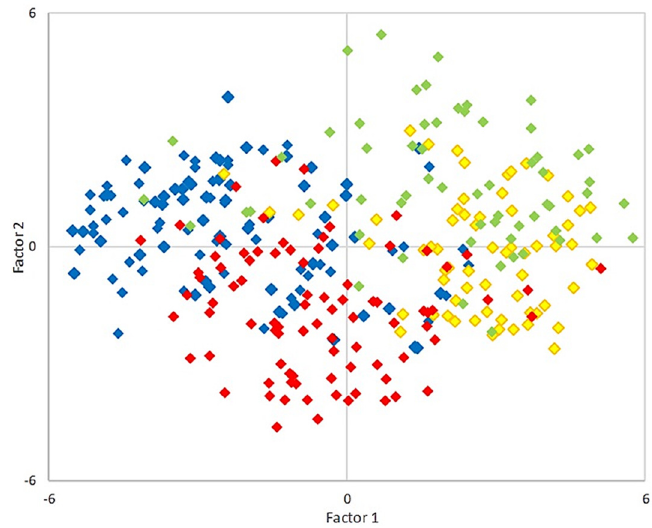
Figure 3. Principal component analysis using the data and parameters in Figure 2, showing the first